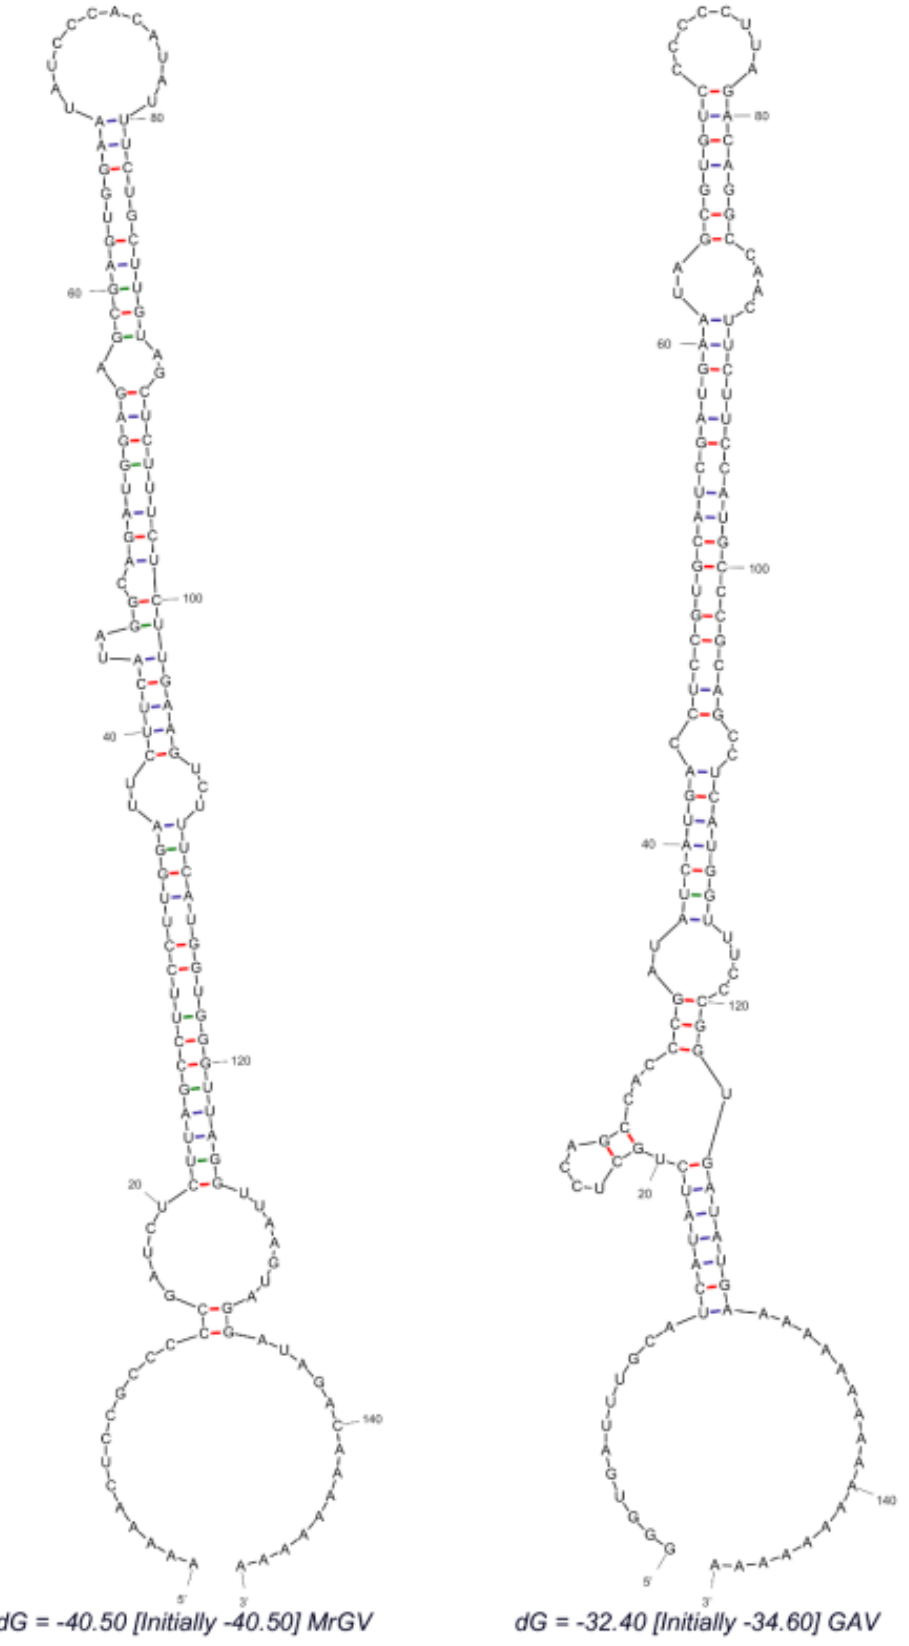
Figure 4. RNA secondary structure predicted using MFOLD of 3 (cid:48) UTR sequences of MrGV and GAV downstream of the stop codon of the final 3 (cid:48)